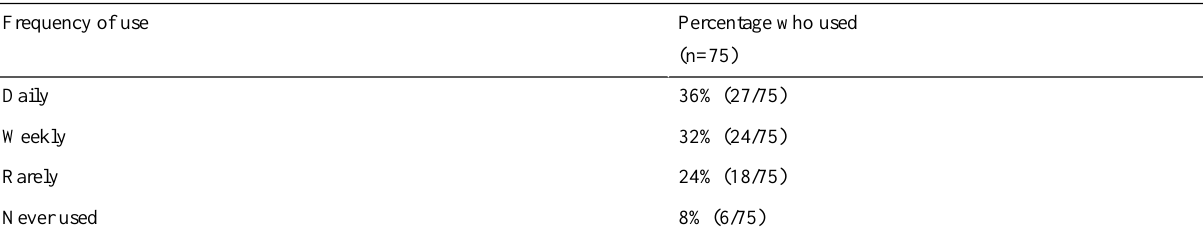
Table 2. Frequency of medical apps used by GPs.